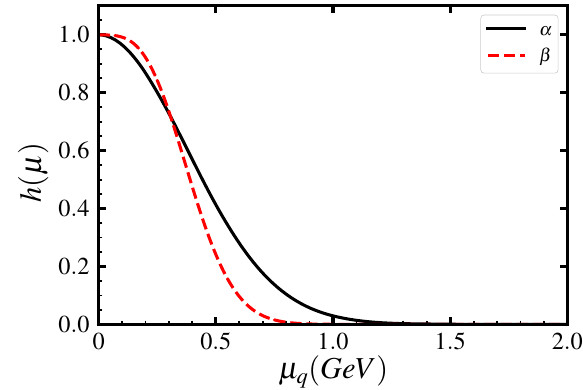
Fig. 3 Calculated quark chemical potential dependence of the mod- ification coefficient h . The black solid line corresponds to the α -type modification function defined in Eq. (14), and the red dashed line cor- responds to the β -type modification function defined in Eq.